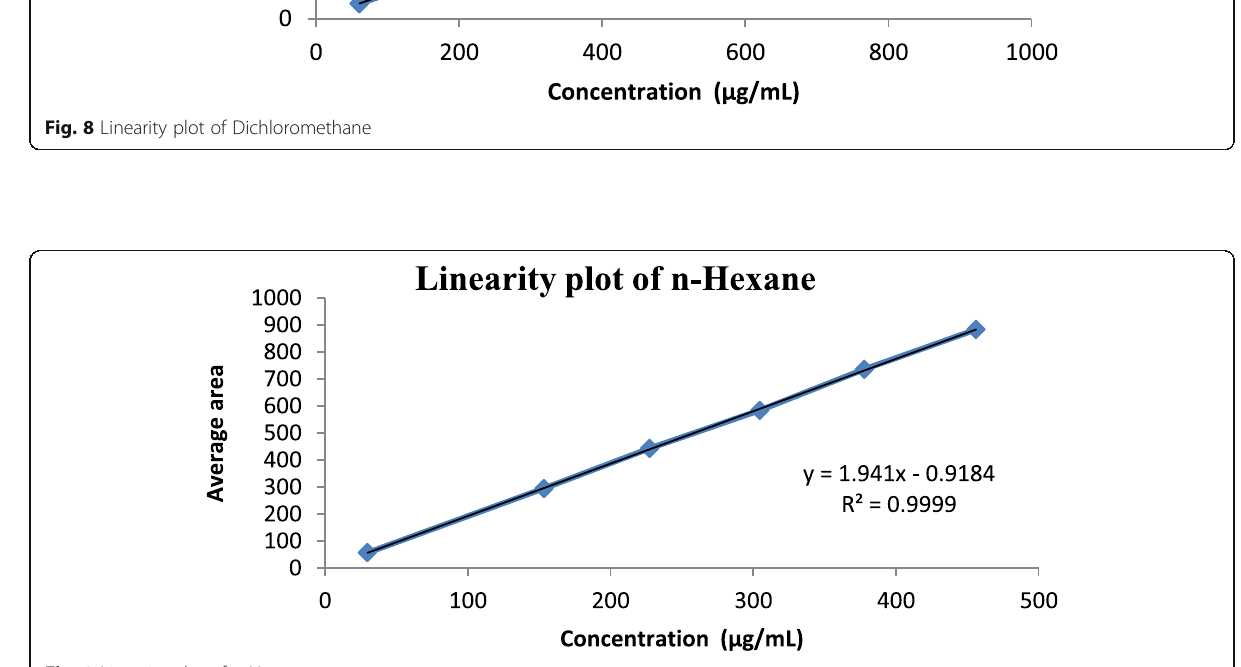
Fig. 9 Linearity plot of n-Hexane